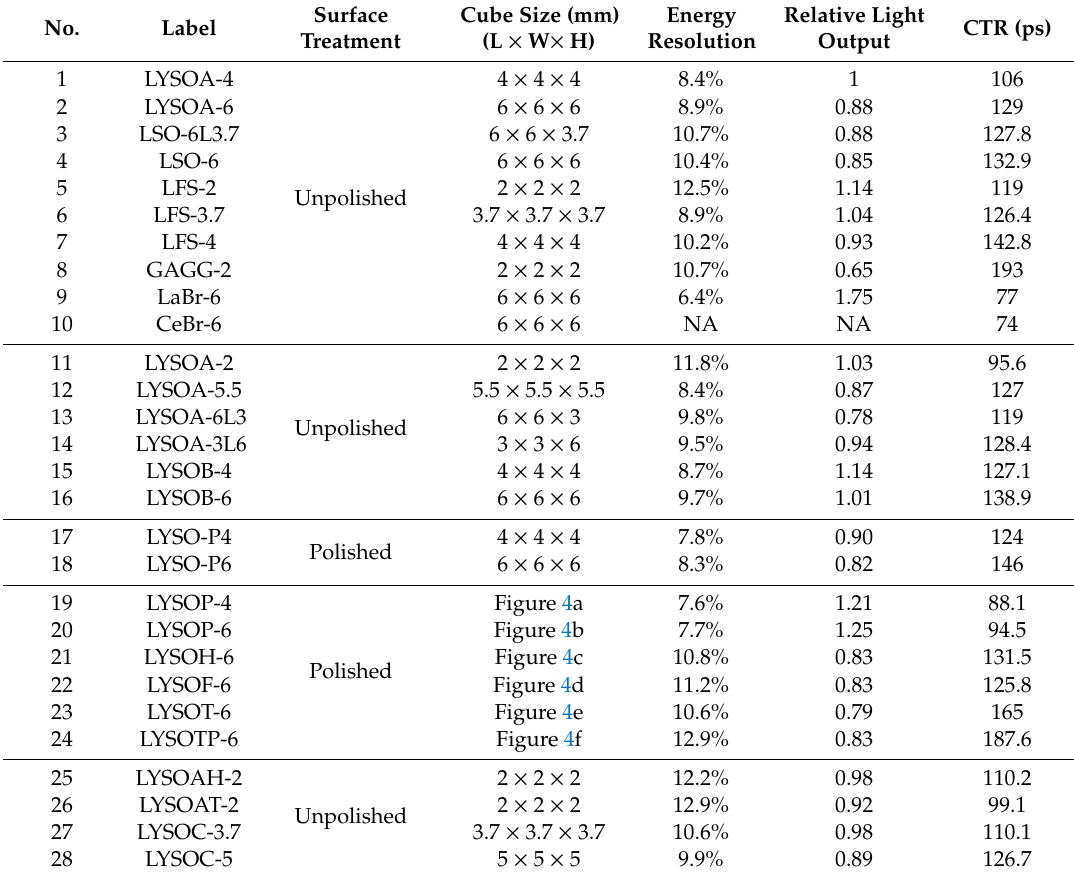
Table 6. Testing results of all the scintillator